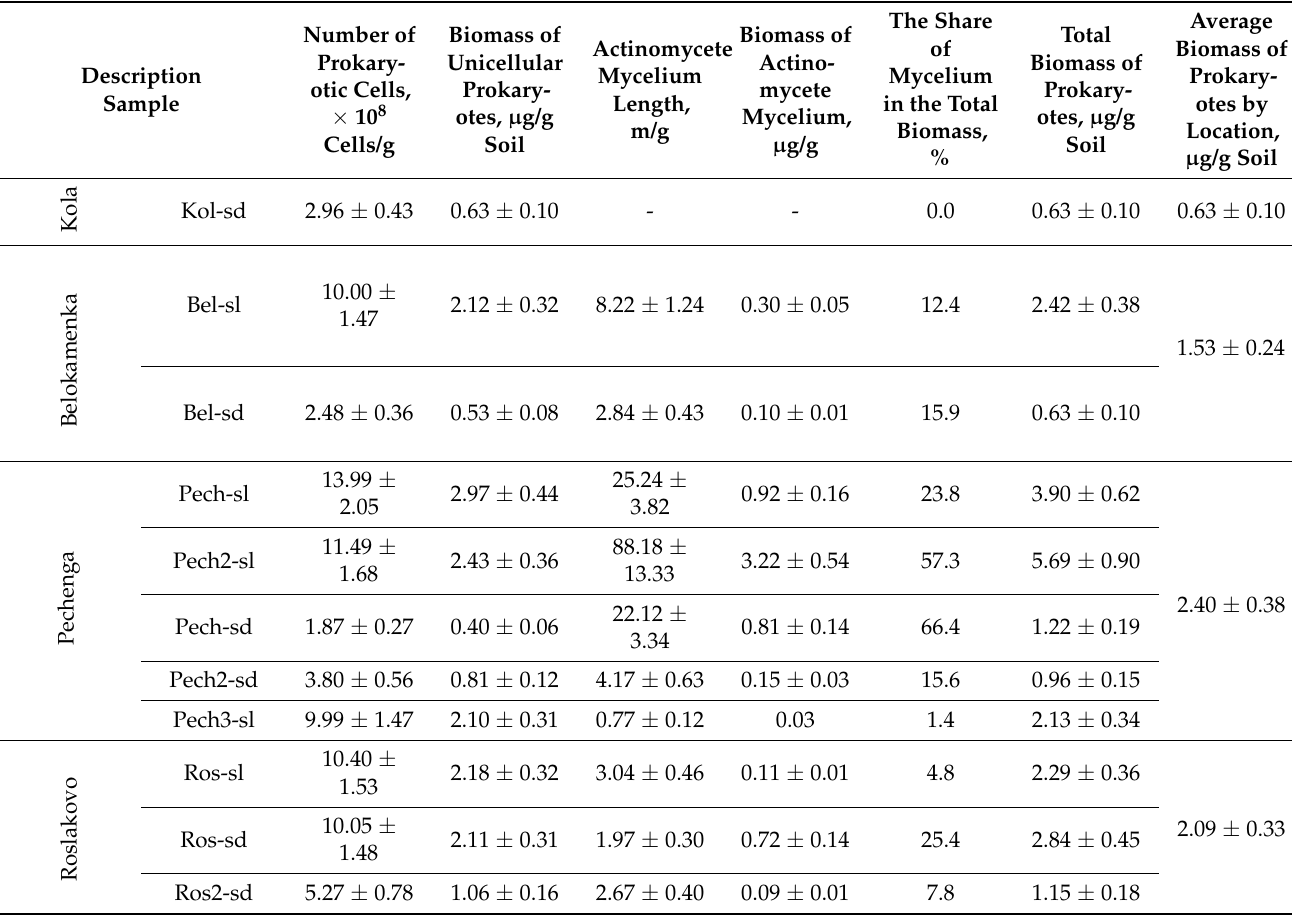
Figure 4. Prokaryotes and fungi under a fluorescent microscope: ( A , C ) prokaryotic cells; ( B , D ) actinomycete mycelium; ( E , F ) mycelium of fungi; ( G ) macrospore of Fusarium sp.; ( H ) massive budding of yeast in plant tissue. Table 3. Structure of the prokaryote’s